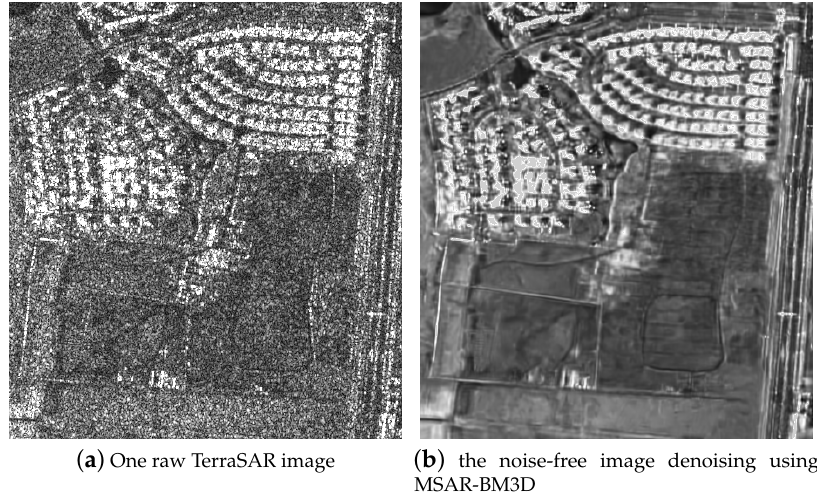
Figure A1. An image before ( a ) and after ( b ) despeckling by